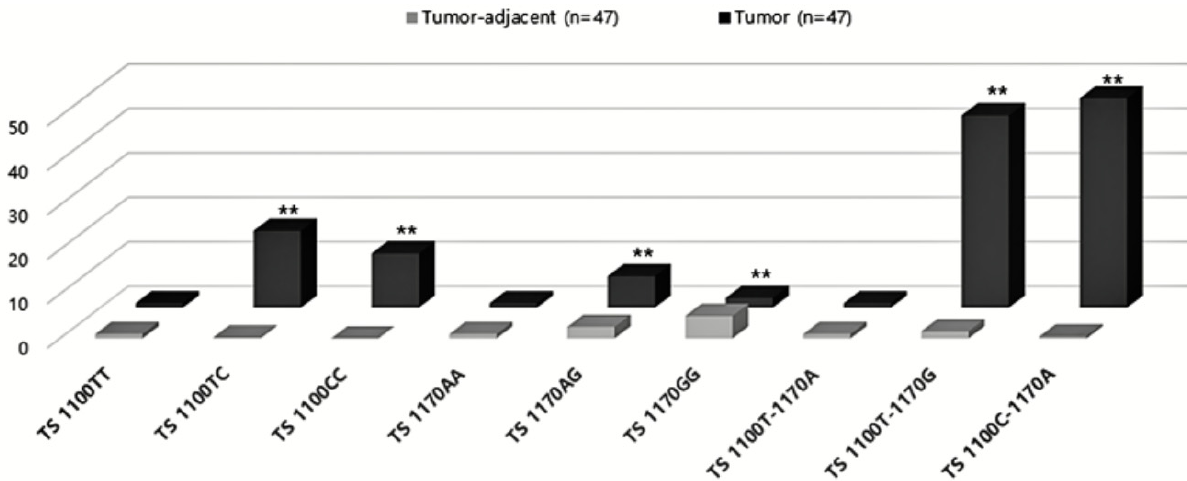
Figure 2. Expression of thymidylate synthase (TS) 1100T>C (rs699517) and 1170A>G(rs2790). Single nucleotide polymorphisms (rs699517 and rs2790) in the 3 ′ -untranslated region (UTR) of TS. Quantitative reverse transcription PCR (qRT-PCR) to measure levels of TS 1100T and 1100C, TS 1170A and TS 1170G, TS 1100T-1170G and TS 1100C-1170A expression in CRC tissue. Means and individual values from three biological replicates are shown. Source data are provided in the source Supplemental Table S5. The housekeeping gene GADPH served as the loading control. ** indicates p < 0.05.